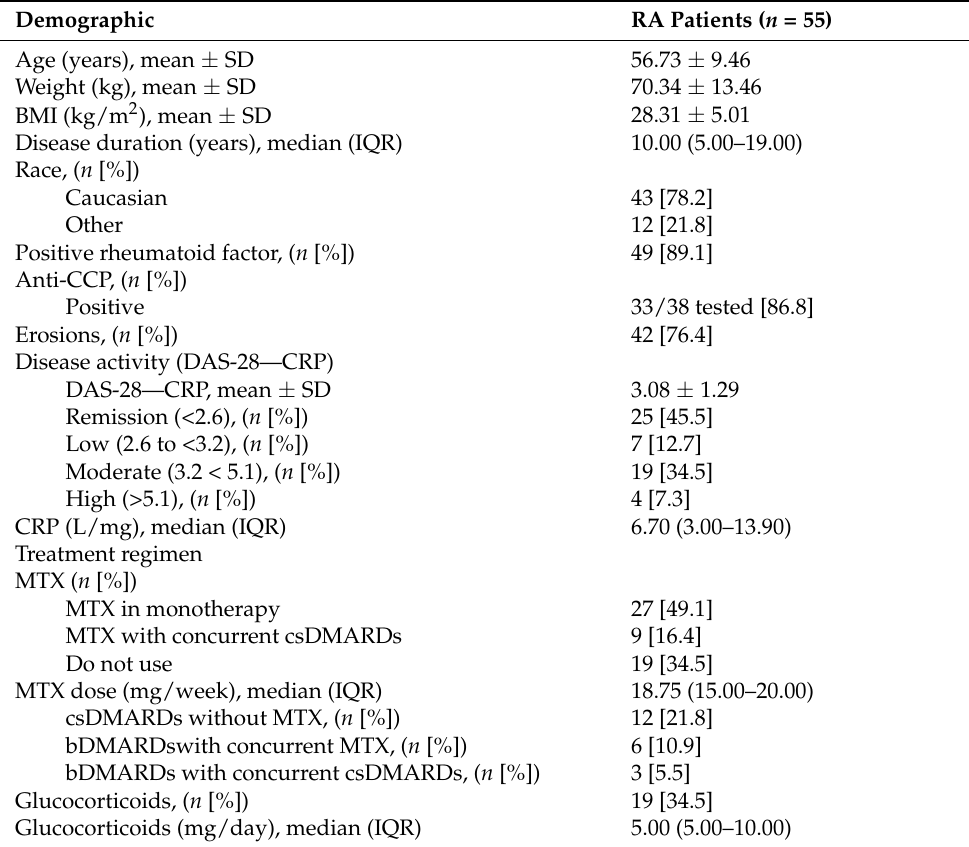
Table 1. Demographic and clinical features of the study